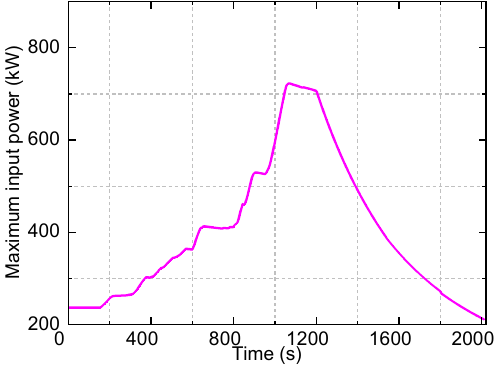
Figure 15. Maximum power of the system.